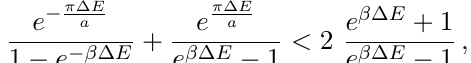
Figure 5 . In (1+1) dimensions the derivative with respect to σ of the quantity ∆ E 2 is plotted for two anti-parallelly accelerating detectors for varying acceleration of the first detector α A . The temperatures of the thermal bath σ and other parameter α B = 1 are